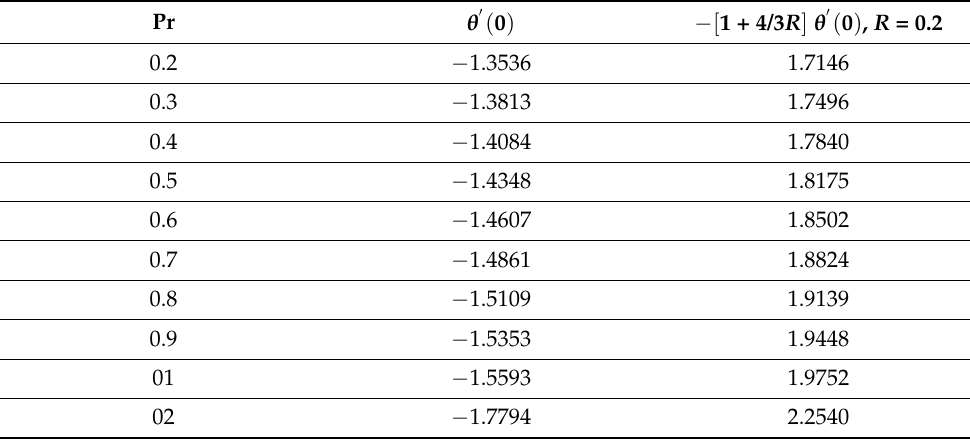
Table 6. Impact of Prandtl number on Nusselt